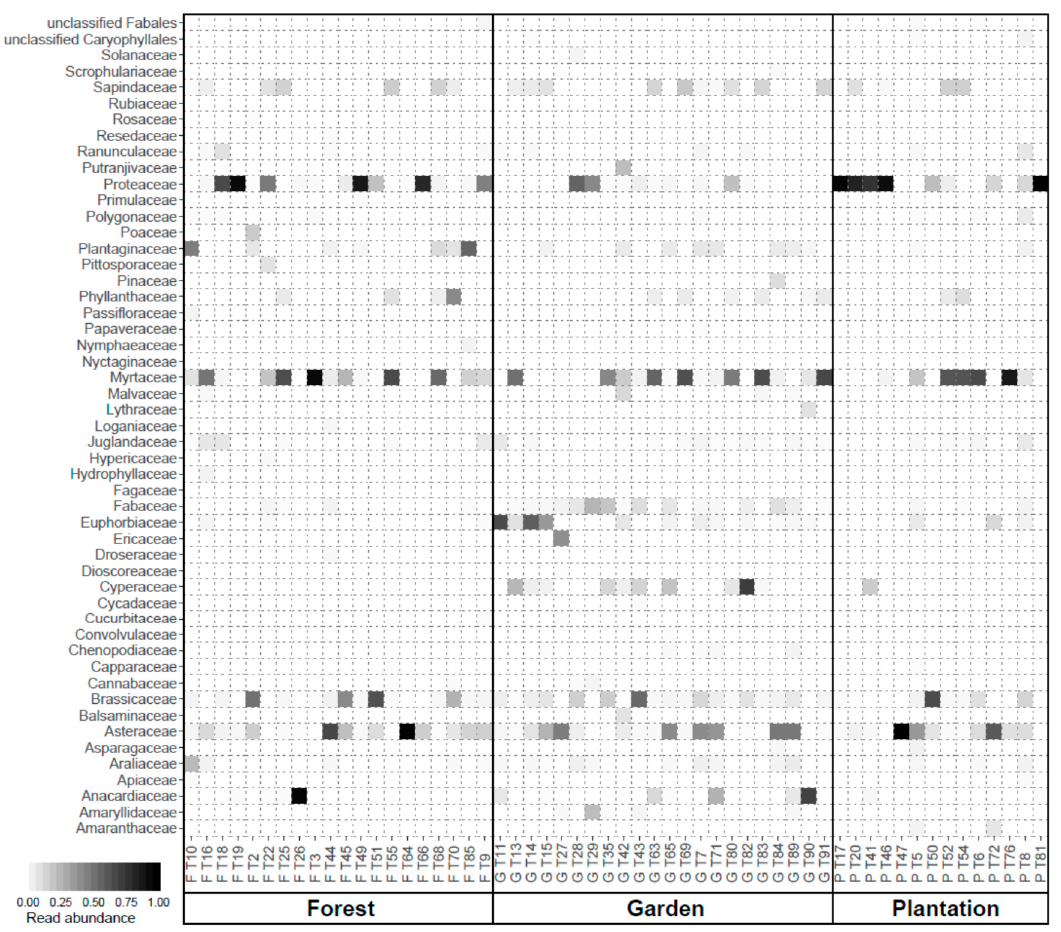
Figure 1. Heatmap of metabarcoding results. The white-to-black gradient of cells represents relative abundances of sequencing read taxonomic assignments on the plant family level (y-axis) for individual sites (x-axis) located in the three different habitats (forest, gardens and plantations), with increasing abundances denoted by darker color. Sequencing reads not assignable to family level are visualized on order level and denoted as “unclassified“.